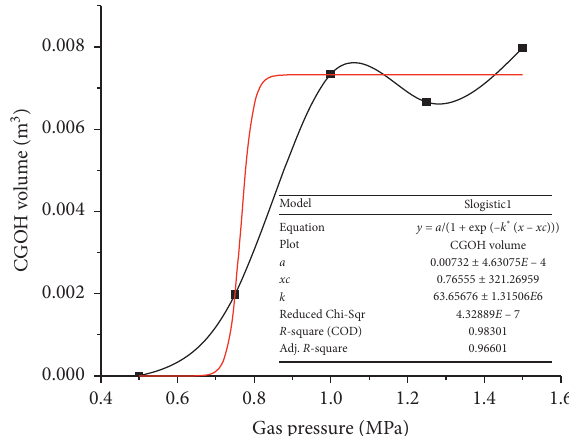
Figure 27: Fitting gas pressure and volume with the Slogistic1 function.